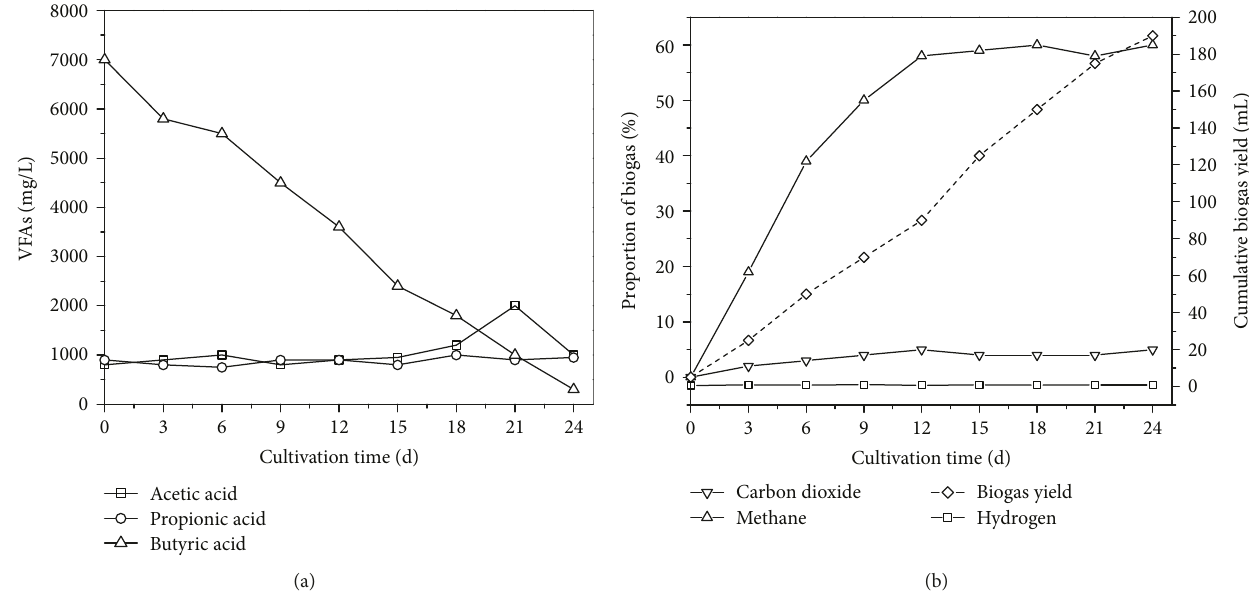
Figure 2: Performance of Z12 through butyric acid degradation (a) and methane production